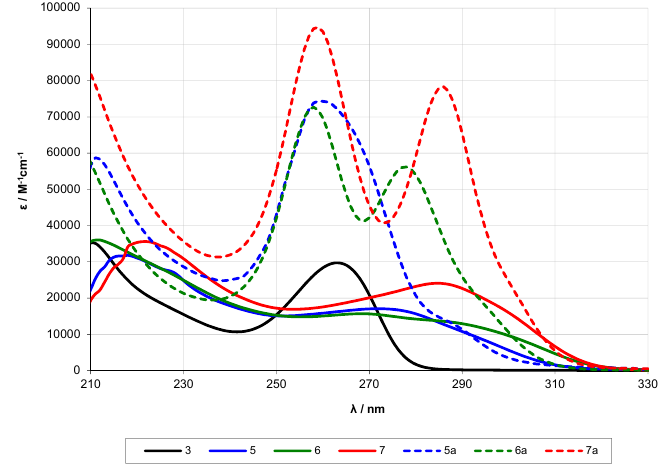
Figure 6. Comparison of the UV spectra of different dodeca-, trideca-, and tetradecasilanes with either methyl or trimethylsilyl groups in terminal and internal positions.